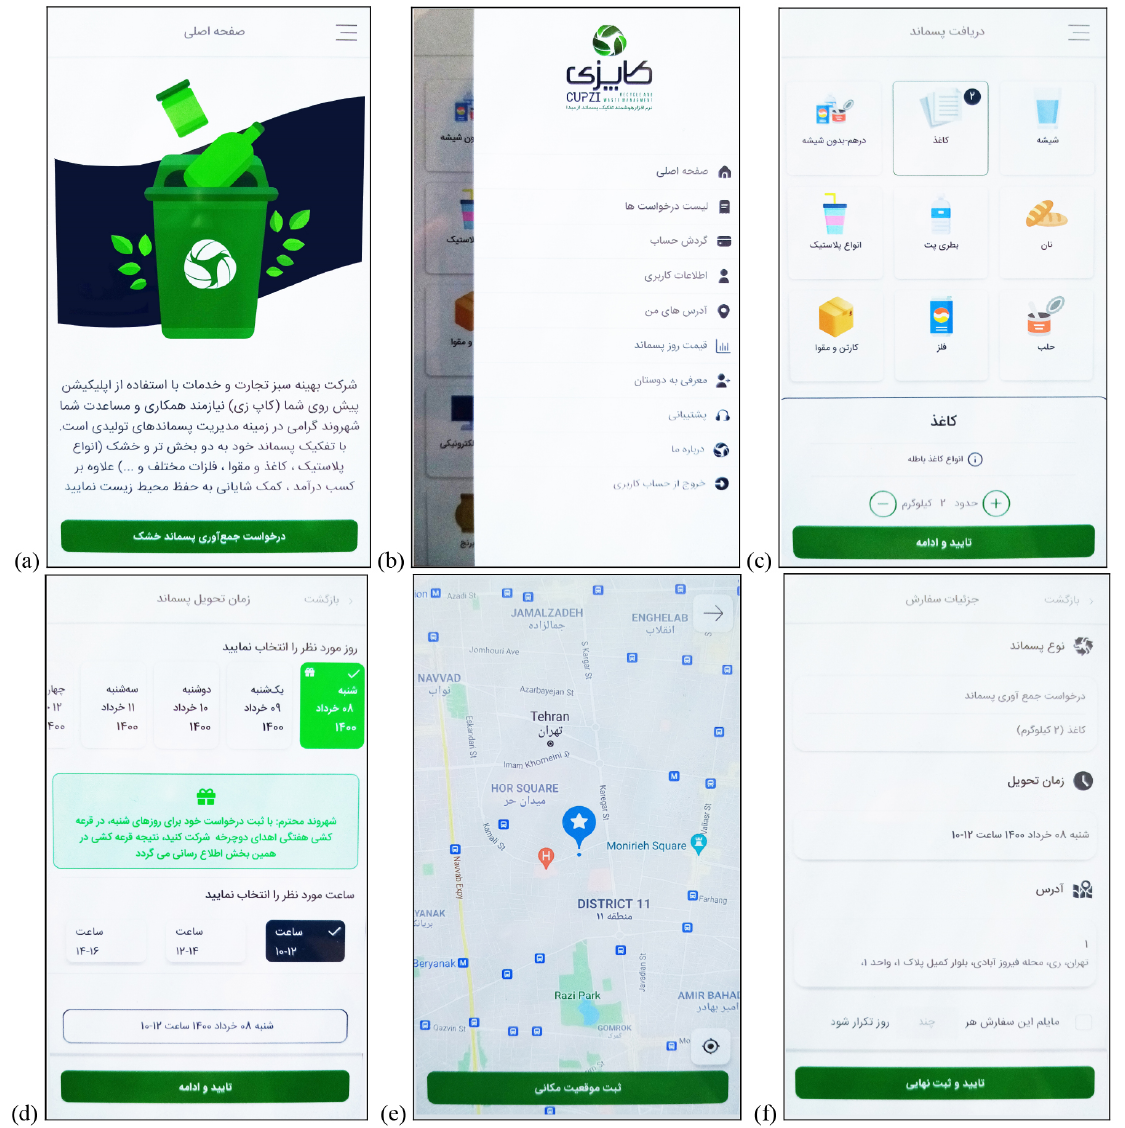
Figure. 1. An example of the demand registration process in RSWC mobile apps in Tehran (CUPZI app), respectively: (a) Home screen, (b) account functionalities, (c) solid-waste type, and weight determination screen, (d) collection day and time setting screen, (e) address registration, and (f) final approval screen (Source: